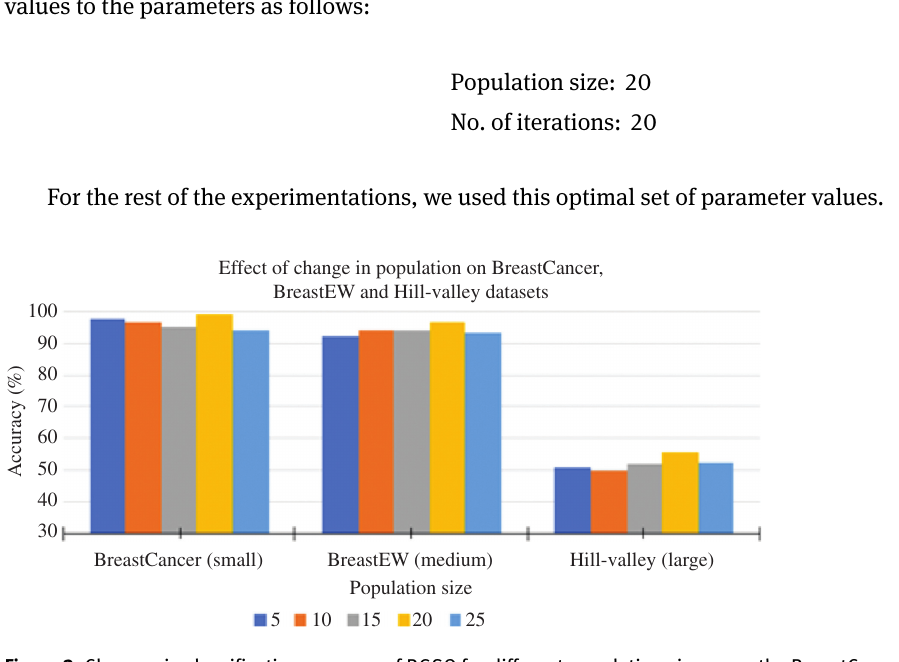
Figure 3: Changes in classification accuracy of BGSO for different population sizes over the BreastCancer, BreastEW and Hill-valley